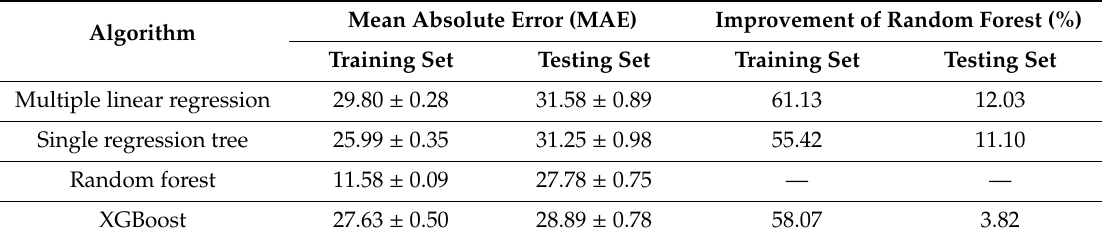
Table 5. Mean absolute error (mean ± standard deviation) of annual EUI for training and testing sets of di ff erent models. Performance improvement by comparing random forest model with other models (%) is provided in the last two columns.